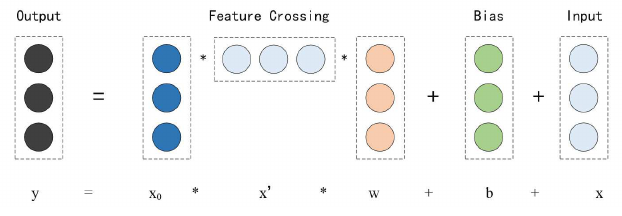
Figure 2. The calculation of an